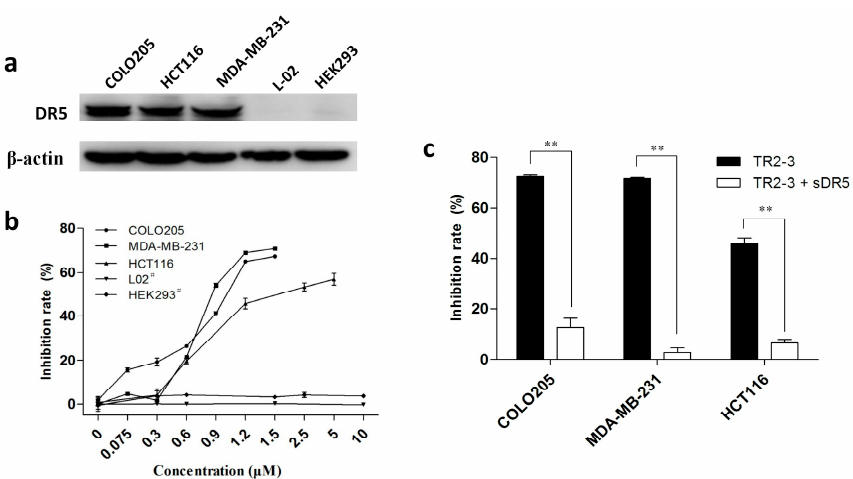
Figure 6. The cytotoxicity of TR2-3 to cancer cells and normal cells. ( a ) DR5 expression level of each cell line was detected by Western blot. Whole-cell lysates from the indicated cell lines were analyzed using antibodies specific to DR5. β -actin was shown as a loading control; ( b ) Cell lines were incubated with TR2-3 at the indicated concentrations for 48 h. # indicates an incubation time of 72 h; ( c ) Cells were incubated with 1.2 μ M TR2-3 as well as with 1.2 μ M or without soluble DR5. Cell viability was measured by MTT assay. The data represent mean growth inhibition as a percentage of untreated cells in each cell line (** p < 0.01, t -test). These data are representative of at least three independent experiments.